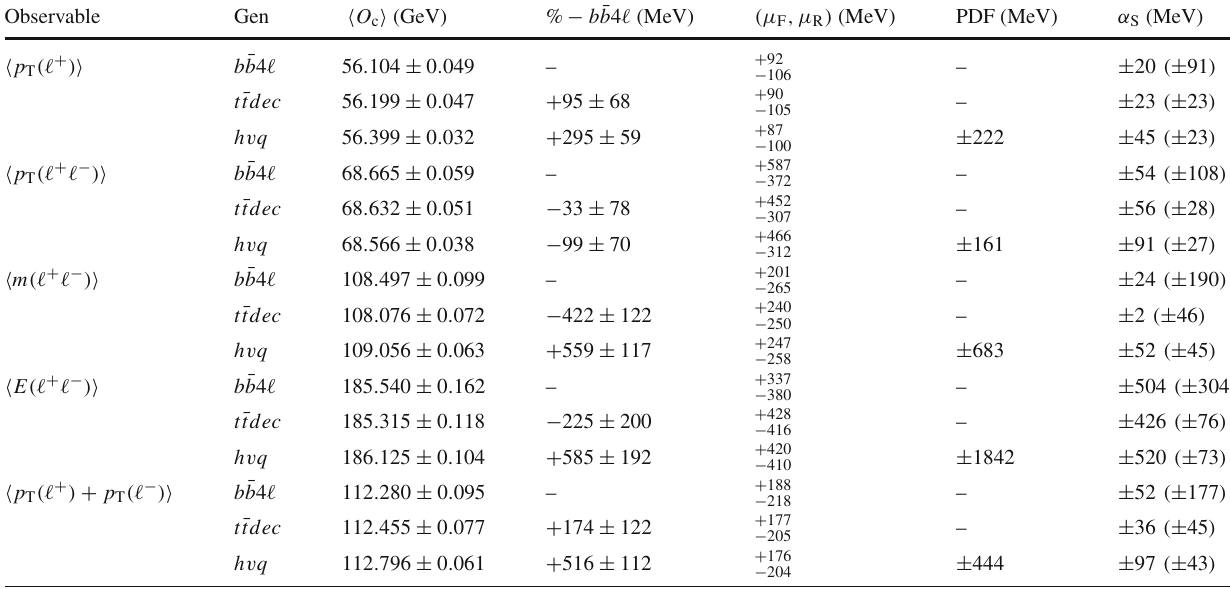
Table 20 As in Table 19 but for Herwig7.1 Observable